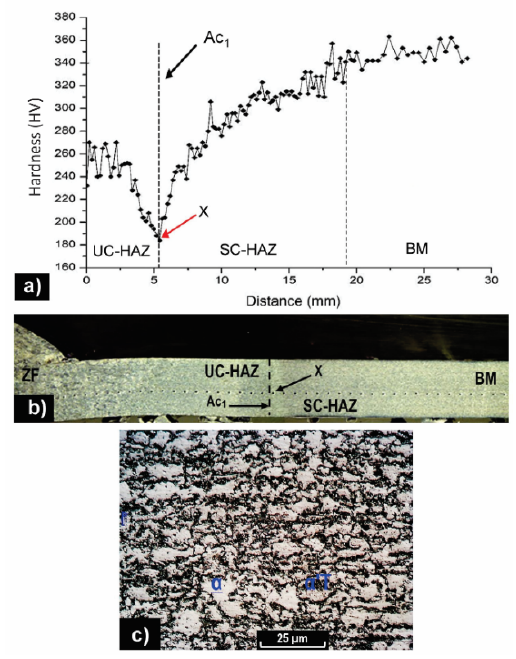
Figure 5. DP980 steel subjected to GMAW: ( a ) microhardness indentations profile across the weld- ment, ( b ) weld cross-section showing the sub-critical HAZ, ( c ) microstructure revealing martensite tempering located just beside the Ac1 line (obtained from “X”).